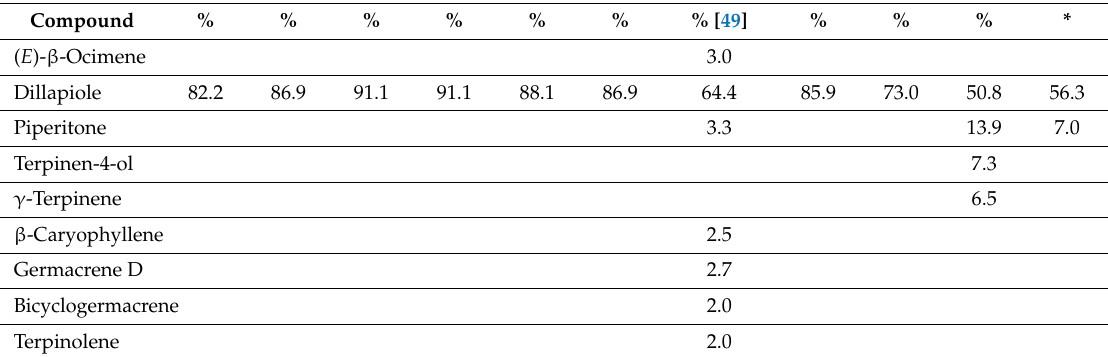
Table 3. Chemical composition (%) of Brazilian Piper aduncum essential oils from aerial parts